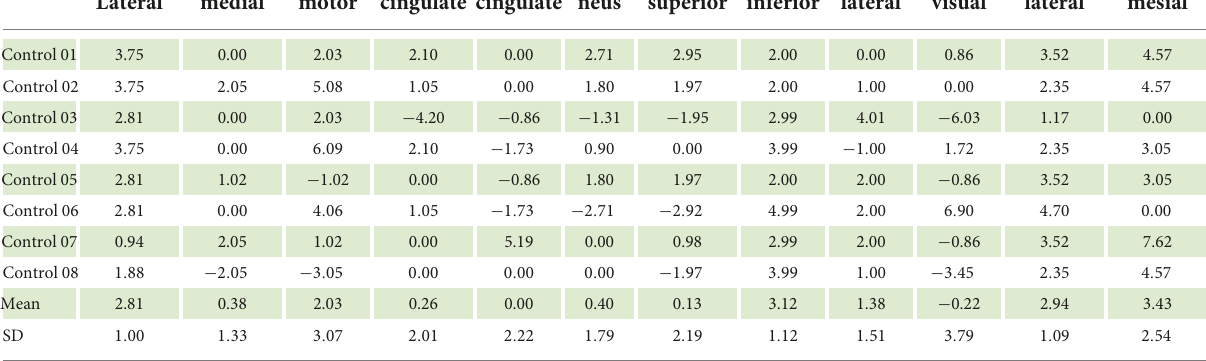
TABLE 4 Brain laterality in control group using global as the reference region ( n =